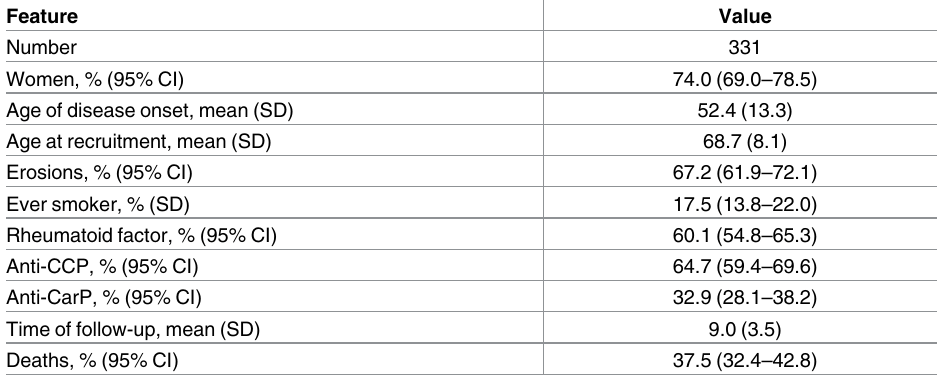
Table 1. Main characteristics of the patients included in this